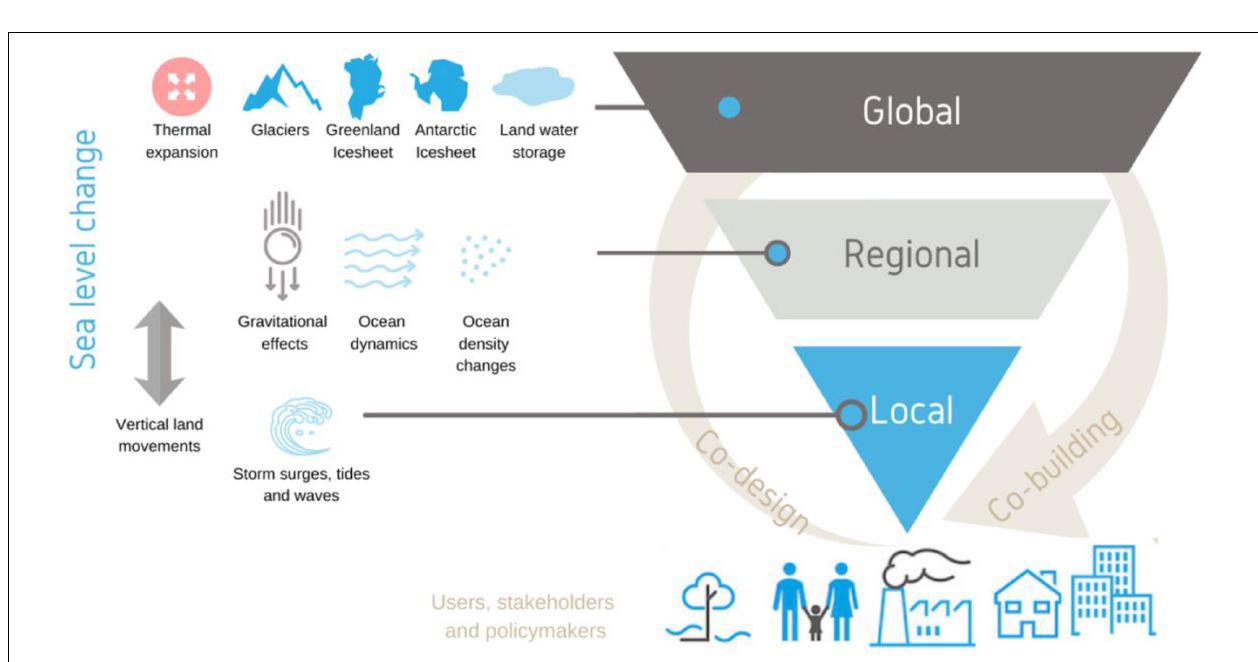
FIGURE 2 | Providing reliable coastal adaptation services requires considering a large variety of processes on a wide range of scales. It should be iteratively co-designed and built with local users stakeholders, and policymakers.